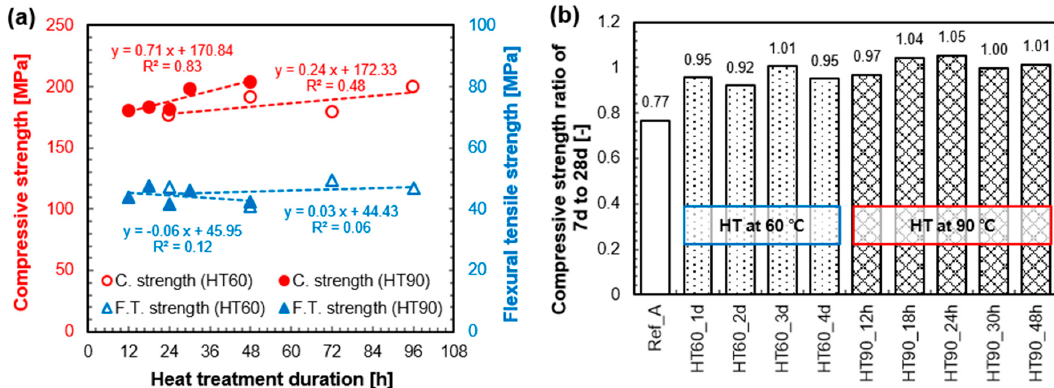
Figure 10. 28 day-strength of UHPC as a function of HT temperature and duration ( a ); and compressive strength ratio of 7 days to 28 days ( b ).